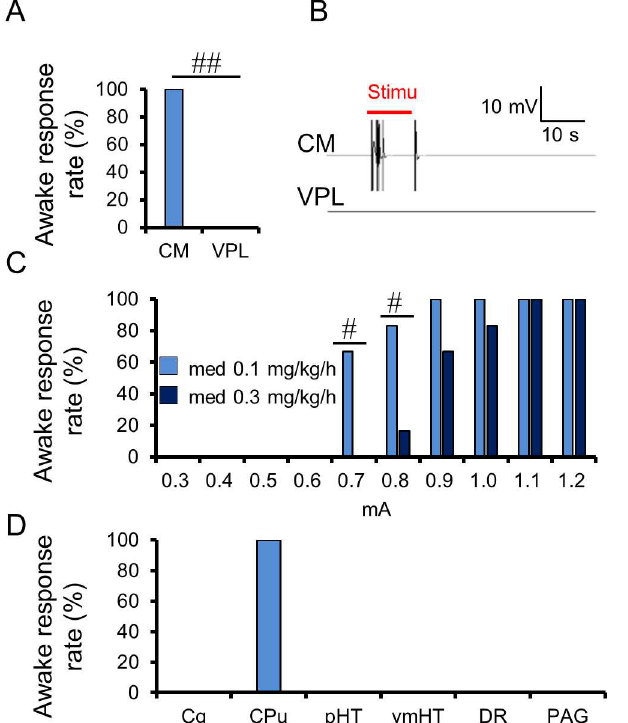
Fig 4. Effects of electrical stimulation of the Central Medial thalamus nucleus (CM) on anesthetic status. (A) Percentageof animals exhibiting an awake responseduringthe electrical stimulationat the CM and VPL under 0.1 mg/kg/h medetomidine condition( n = 6). (B) Representative electromyography (EMG) signalsof the stimulation,with 0.8 mA amplitudeat the CM and the VPL under 0.1 mg/kg/h medetomidine. (C) Percentage of animalsexhibitingan awake responseduringthe electricalstimulationat the CM, with an amplitudeof 0.3–1.2 mA under 0.1 and 0.3 mg/kg/h medetomidine ( n = 6). (D) Percentage of animals exhibiting an awake responseduring the electrical stimulationat the six brain locationsunder 0.1 mg/kg/h medetomidine ( n = 4). # p < 0.05, ## p < 0.01 (Fisher’s exact test). Data for minimum amplitudes of individual rats can be found in S5